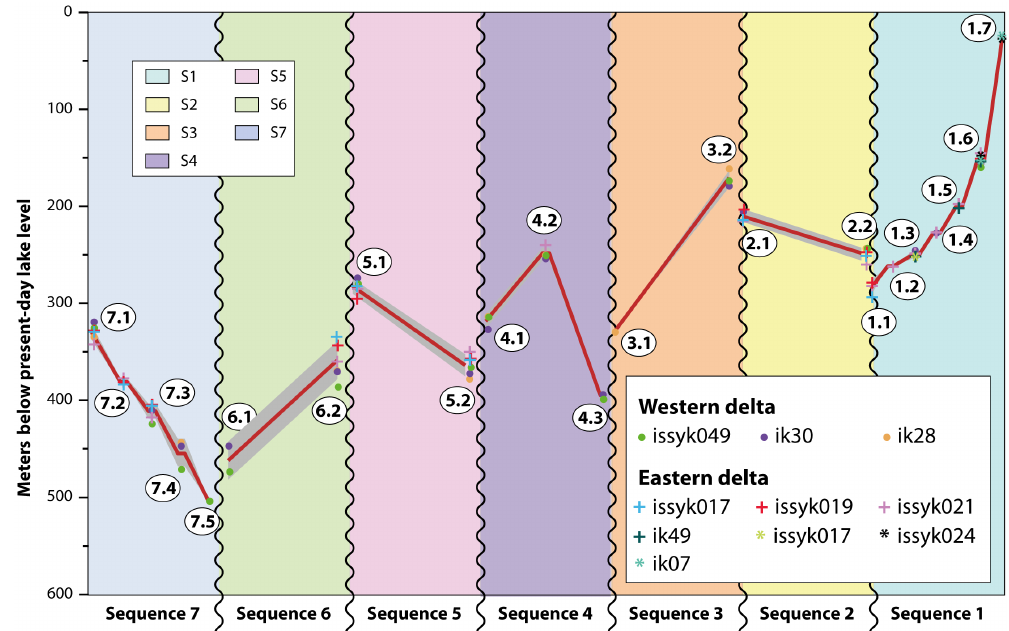
Figure 9. Lake-level curve of Lake Issyk-Kul. Red line: mean value of delta depths. Gray shading: standard deviation of delta depths. Numbers correspond to delta numbers in the text and in Table 1. Boundaries in between the different sequences are at least partially